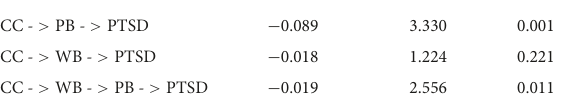
TABLE 5 Specific indirect